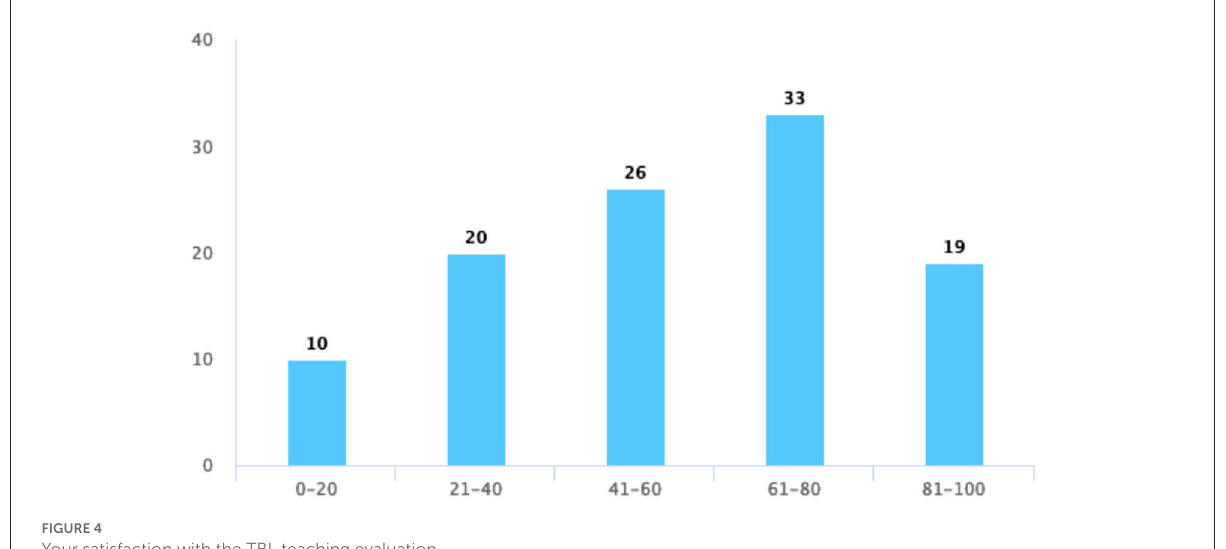
FIGURE4 Your satisfaction with the TBL teaching evaluation.